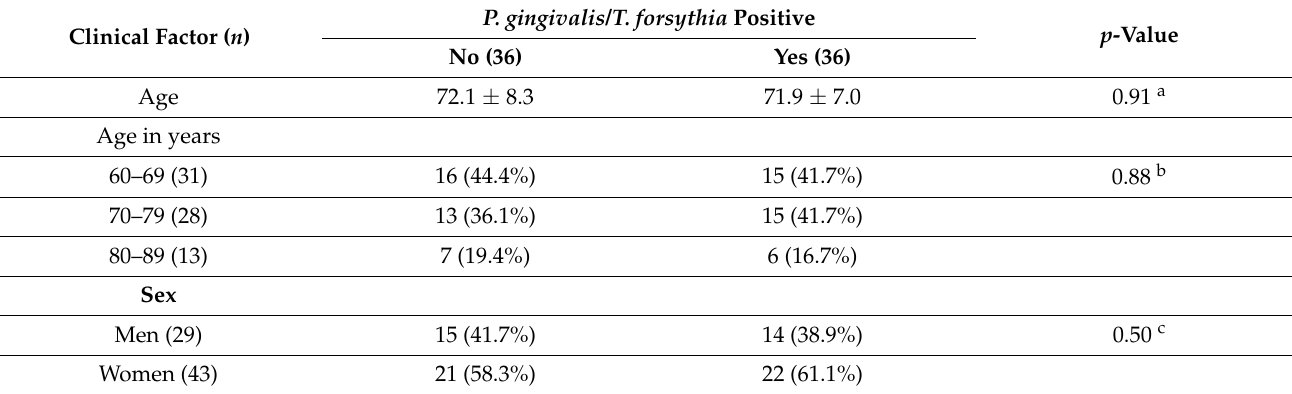
Table 4. Associations of P. gingivalis / T. forsythia presence with PISA and PESA in 72 propensity score-matched patients. Clinical Factor ( n